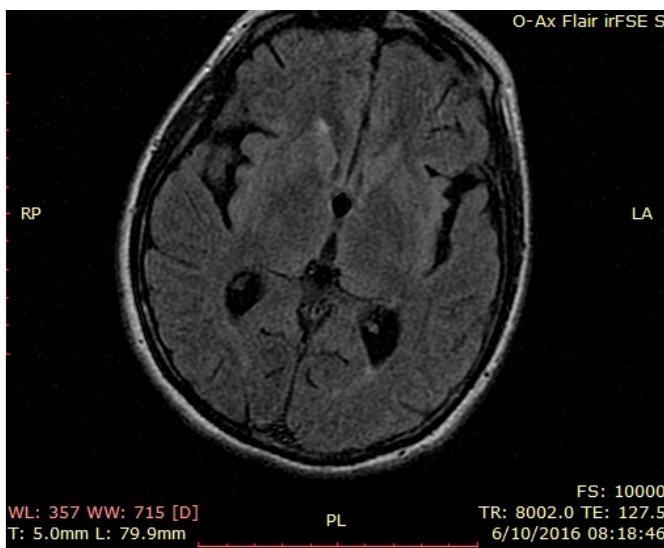
Figure 5. Second brain MRI, FLAIR images, axial insular image.